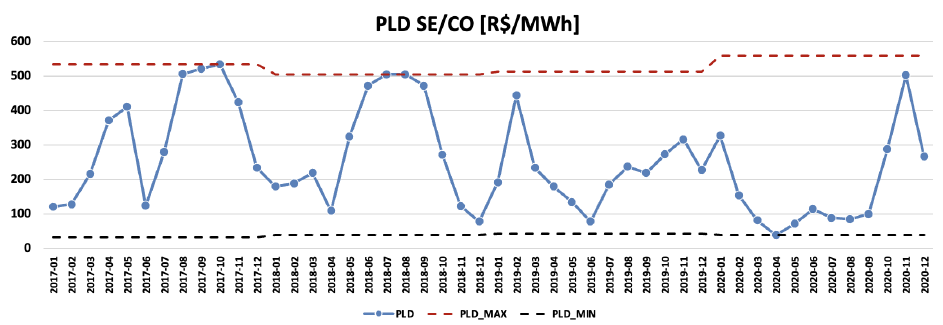
Figure 1. Historical Southeast PLD.